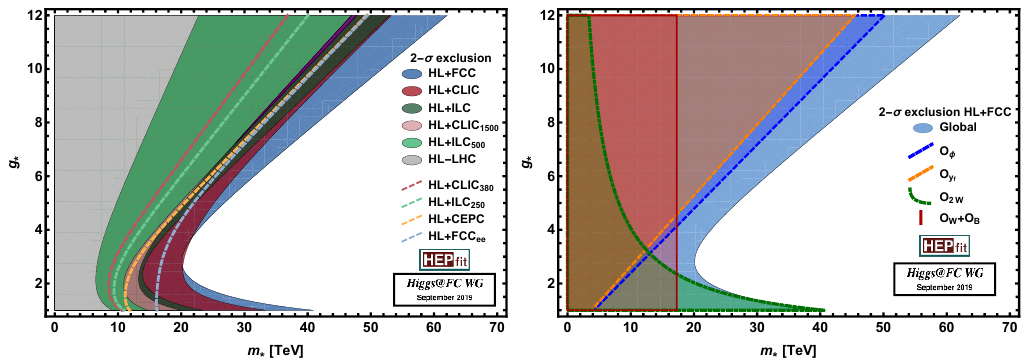
Figure 7 . (Left) 2- (cid:27) exclusion regions in the ( g ? ; m ? ) plane from the (cid:12)t presented in (cid:12)gure 6, using the SILH power-counting described in eq. (3.20) and below (solid regions). Dashed lines indicate the regions constrained by the corresponding low-energy runs (or FCC-ee only for the case of the FCC project). (Right) The same comparing the results from the global (cid:12)t with the constraints set by some of the operators individually, for the illustrative case of the HL-LHC+FCC-ee/eh/hh. In this case, the constraints from the on-shell Higgs measurements mainly a(cid:11)ect O (cid:30) and O y . f have theoretical calculations for the predictions of such processes with comparable or better precision. In this sense, to quantify to what extent an experimental measurement with uncertainty (cid:14) exp can be translated into a constraint on new physics, 17 one needs to know the corresponding uncertainty (cid:14) SM for the SM prediction. In order to extract the maximum experimental information, ideally, (cid:14) SM (cid:28) (cid:14) exp . The sources of the SM uncertainty are typically separated in two types of